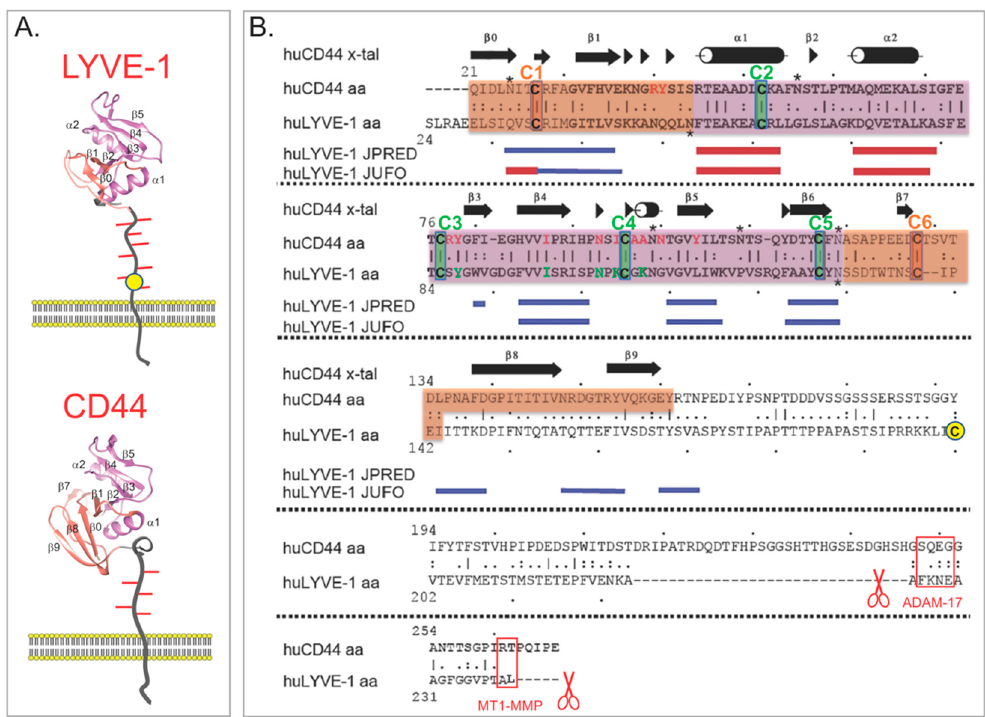
Figure 6. 3D structure of the LYVE-1 HA-binding Link domain. ( A ) Structure-based models of the HA-binding domain in human LYVE-1 based on the high-resolution crystal structure of its closest homologue CD44 [152] below. Illustrations depict membrane-proximal domains in each case decorated with O-linked sugars (red lines). The yellow circle in LYVE-1 represents the unpaired cysteine residue C201 involved in homodimer formation (see Figure 5). ( B ) Alignment of the human LYVE-1 and CD44 amino acid sequences highlighting the regions encoding the conserved disulphide-bridged α / β fold of the consensus Link domain (mauve) and the β stranded N- and C-terminal extensions peculiar to CD44 (orange) stabilised by the additional disulphides C1-C6 and C2-C5 predicted to be present also in LYVE-1 from secondary structure program analysis using JPRED and JUFO. Notably in LYVE-1, the β 8 and β 9 strands of the C-terminal extension are substituted by serine and threonine-rich tracts that predict formation of an elongated, O -glycosylated membrane-proximal stalk [146]. Asterisks mark amino acid motifs (NXS/T) for N-glycosylation. Sites for LYVE-1 ectodomain cleavage (scissors symbol) by MMPs and ADAMs are boxed in red. The figure is modified from Jackson (2019) [23] with permission from the publisher (Elsevier).